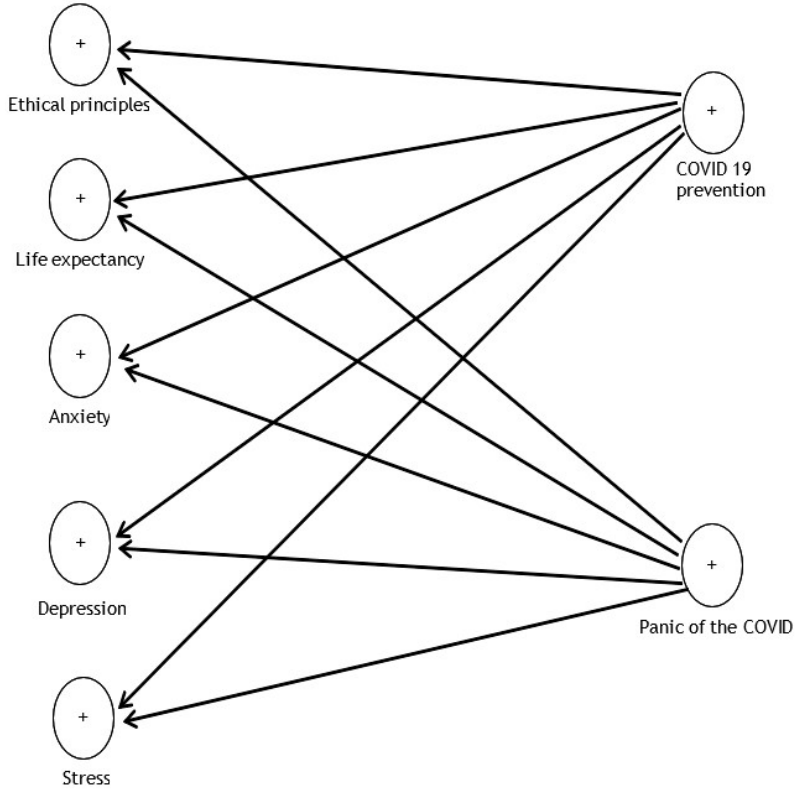
Figure 1. Research